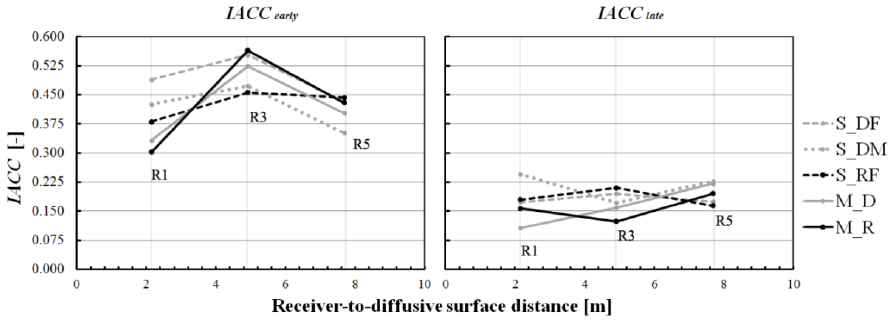
Figure 8. IACC early and IACC late as a function of the distance from the variable wall.